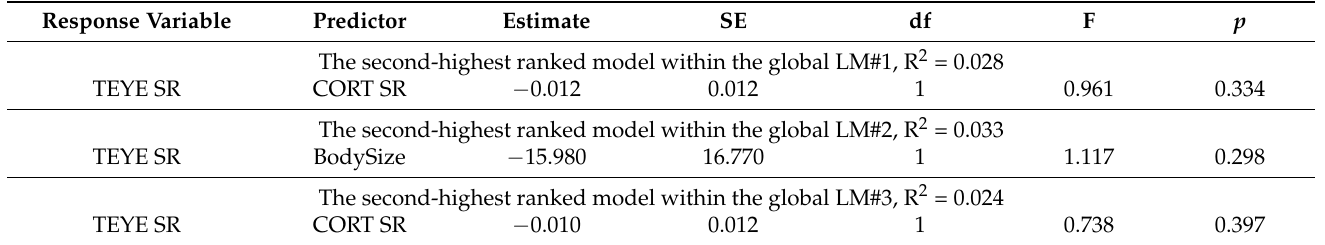
Table 4. The highest-ranked linear models with combinations of predictors included in the global models listed in Table 3 estimating the effects of various predictors on thermal stress response (eye-region temperature—TEYE SR) in Little Auks in capture-restraint experiment. CORT SR— corticosterone stress response and BodySize—total head length. SE—standard error, df—degrees of